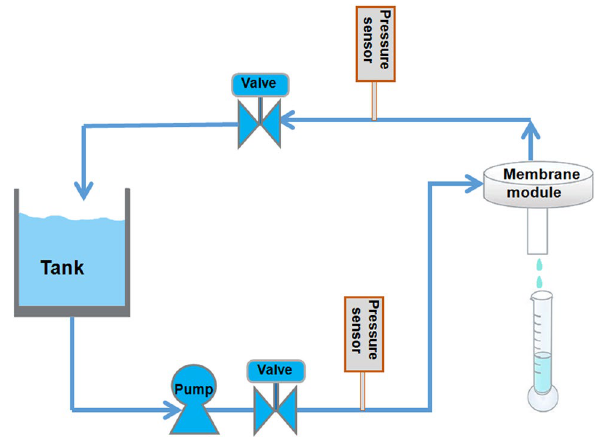
Fig. 2 The flowchart of the PWF measurement equipment